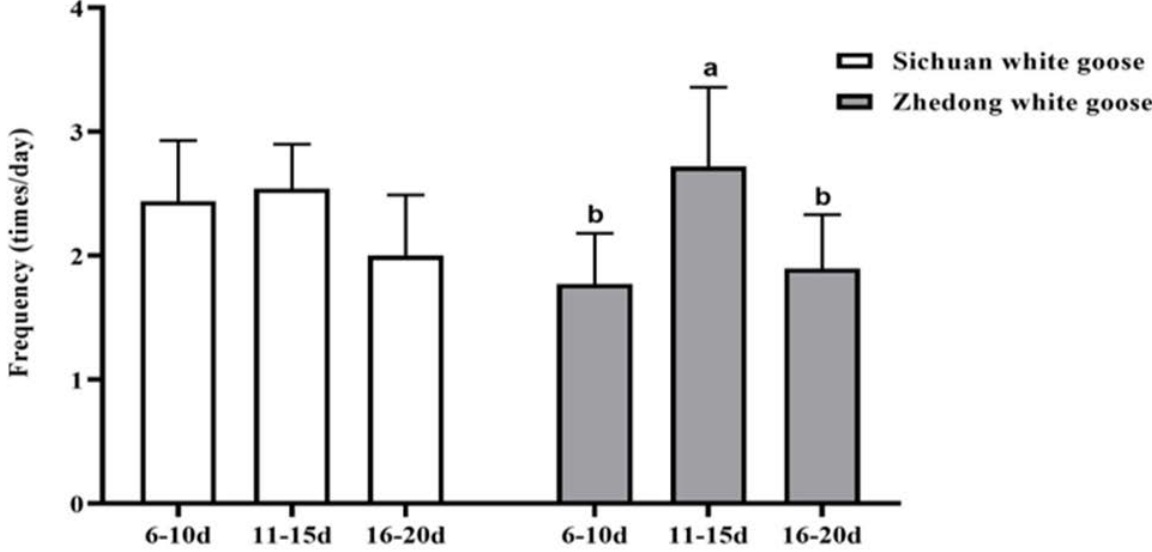
Figure 3. Effects of the time spent together with opposite sexes on successful copulation. The frequencies of successful copulation were assessed on days 6–10, 11–15, and 16–20 after the geese were mixed. a,b Different letters denote significant differences ( p < 0.05).